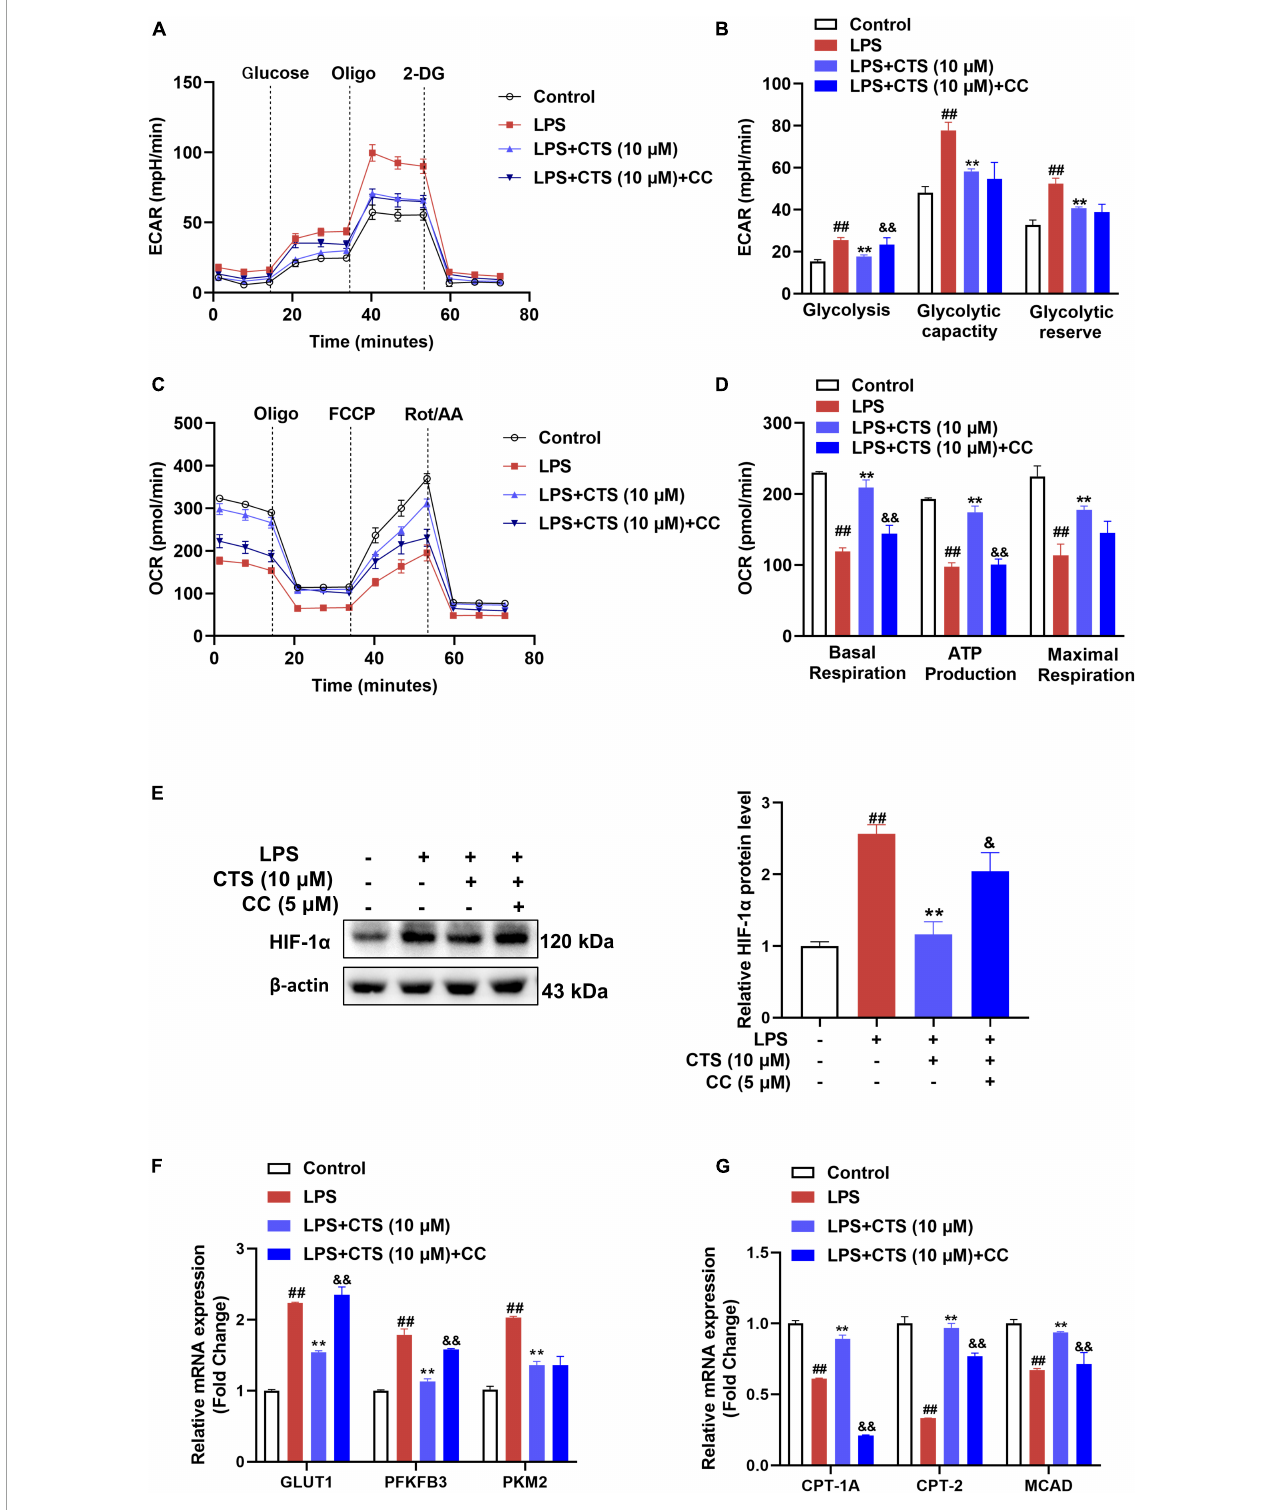
FIGURE6 Cryptotanshinone (CTS) regulates energy metabolism of LPS-induced RAW264.7 macrophages through AMPK. RAW264.7 pretreated with 5 µ M AMPK inhibitor compound C for 2 h were treated with 10 µ M CTS for 2 h and then exposed to LPS for another 24 h. (A) ECAR of the indicated macrophages were measured with a seahorse analyzer. (B) Glycolysis, glycolytic capacity, and glycolytic reserve were calculated and are indicated as ECAR in mpH/min, n = 4. (C) OCR was measured with the Seahorse analyzer. (D) The basal respiration, maximal respiration, and ATP production were calculated and are indicated as OCR in pmoles/min, n = 4. (E) The protein level of HIF-1 α was analyzed by using western blotting assay, n = 3. (F) The mRNA expressions of glucose transporter type1 (GLUT1), 6-phosphofructo-2-kinase/fructose-2,6-biphosphatase 3 (PFKFB3), pyruvate kinase M2 (PKM2) were detected by using the qPCR assay, n = 3. (G) The mRNA expressions of carnitine palmitoyltransferase 1A (CPT1A), carnitine palmitoyltransferase 2 (CPT2), medium-chain acyl-coA dehydrogenase (MCAD) were detected by using the qPCR assay, n = 3. Data were presented as the mean ± SEM. ## P < 0.01 vs. the control group; * P < 0.05, ** P < 0.01 vs. the LPS group; & P < 0.05, && P < 0.01 vs. the LPS + CTS (10 µ M)